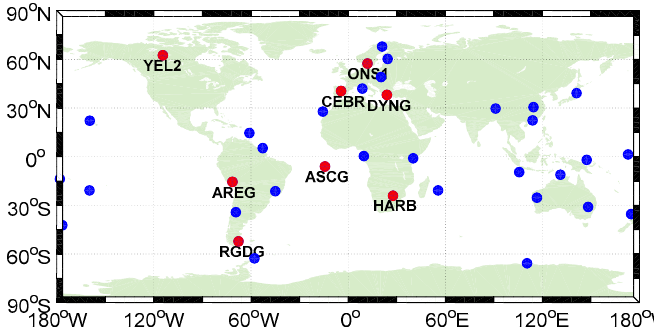
Figure 2. Distribution of MGEX stations used for UPD estimation and PPP ambiguity resolution. The blue dots indicate the reference stations, while the red dots denote the user stations.